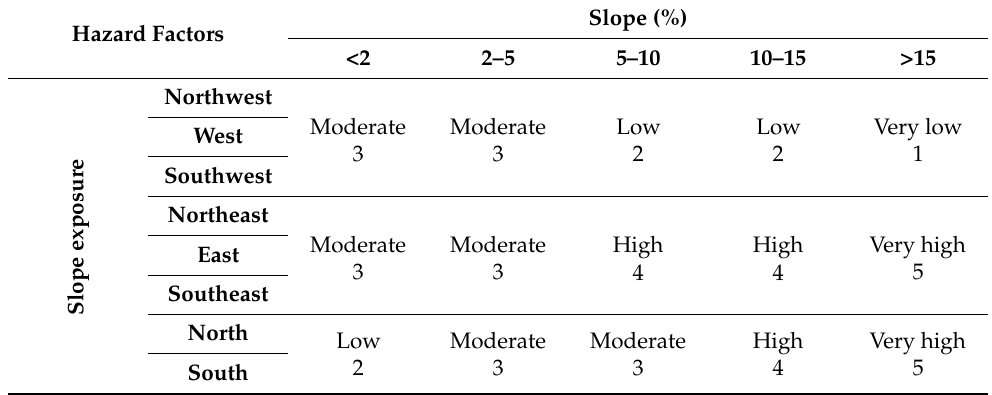
Table 7. Hazard classification concerning the slope and slope exposure hazard factor.